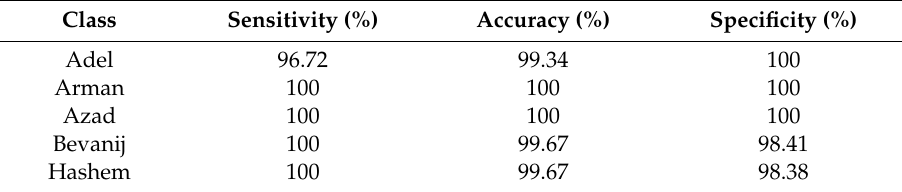
Table 7. Performance criteria related to the confusion matrix using the featureless approach. Class Sensitivity (%) Accuracy